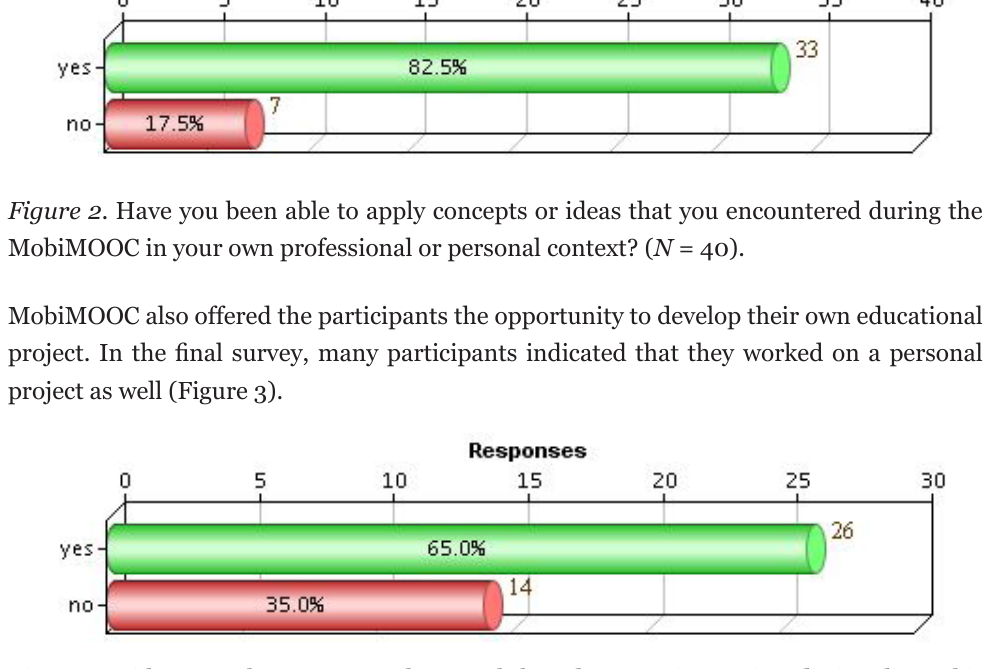
Figure 3 . Did you work on a personal research-based mLearning project during the Mobi - MOOC? ( N =